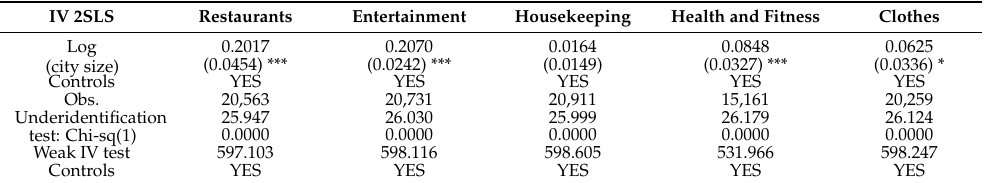
Table 5. IV 2SLS estimates on the effect of city size on household expenditures; control variables are